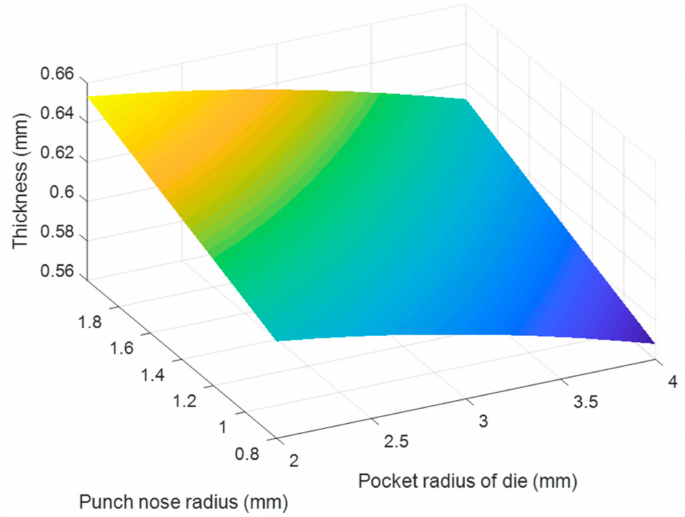
Figure 22. The effect of punch nose radius and pocket radius of die on